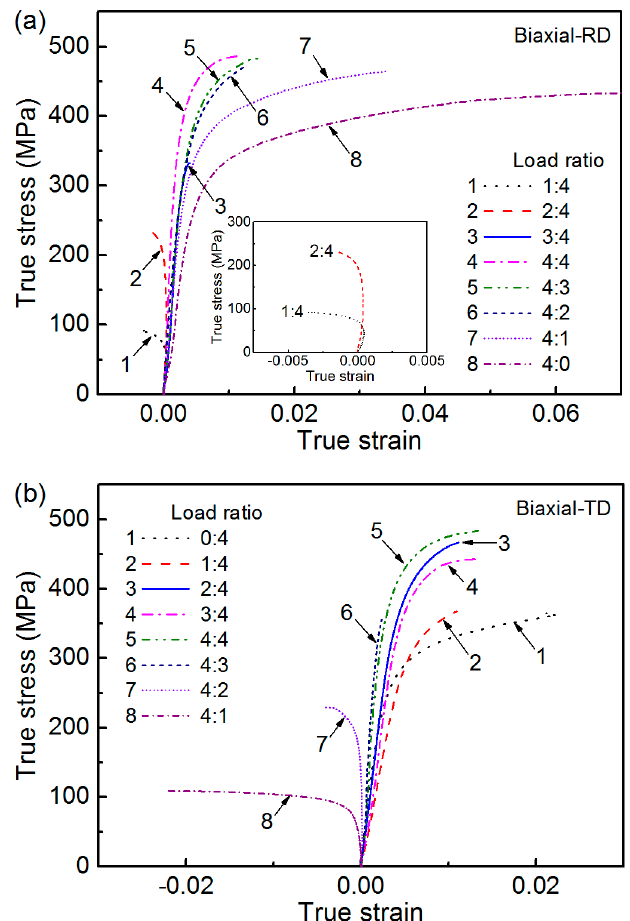
Figure 7. True stress-strain curve of CP-Ti at different load ratios: ( a ) RD, ( b ) TD.